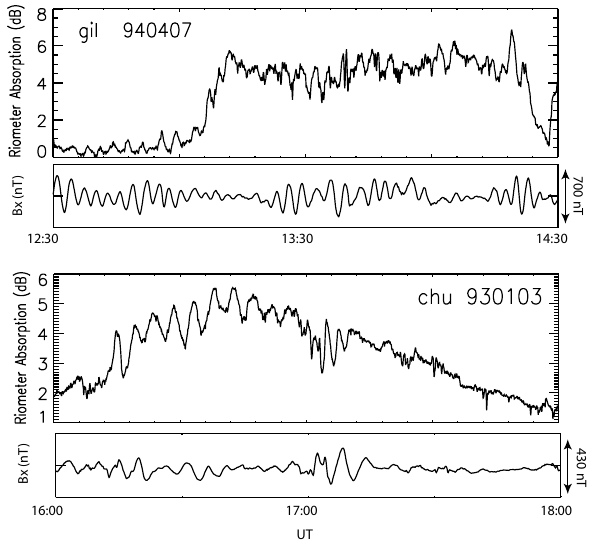
Fig. 2. Example Pc5 pulsations seen in both the magnetometer and riometer.